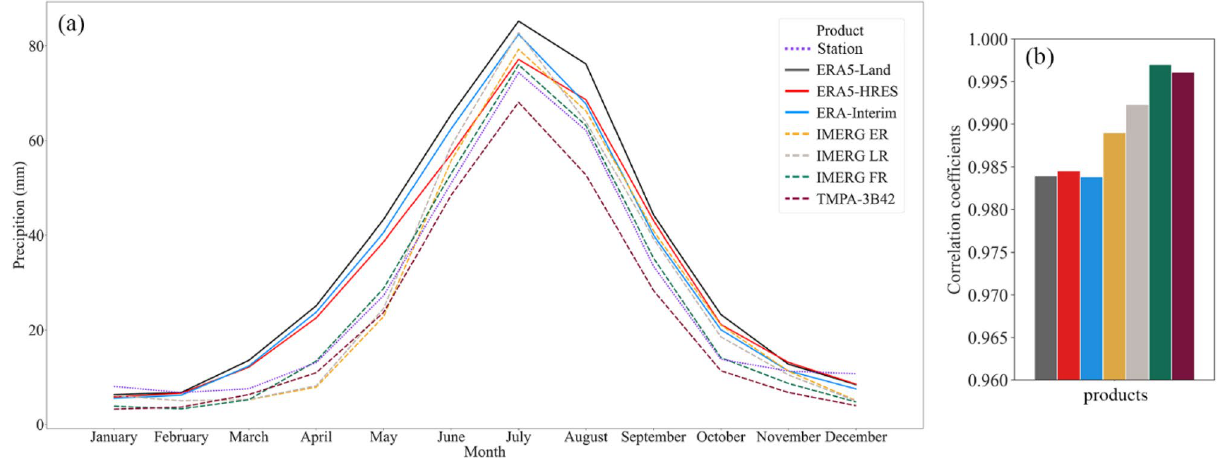
Figure 2. Ability of each product to describe seasonal precipitation cycles: ( a ) monthly cycles of products and ground-based stations, and ( b ) Pearson correlation coefficients between the product and station cycle